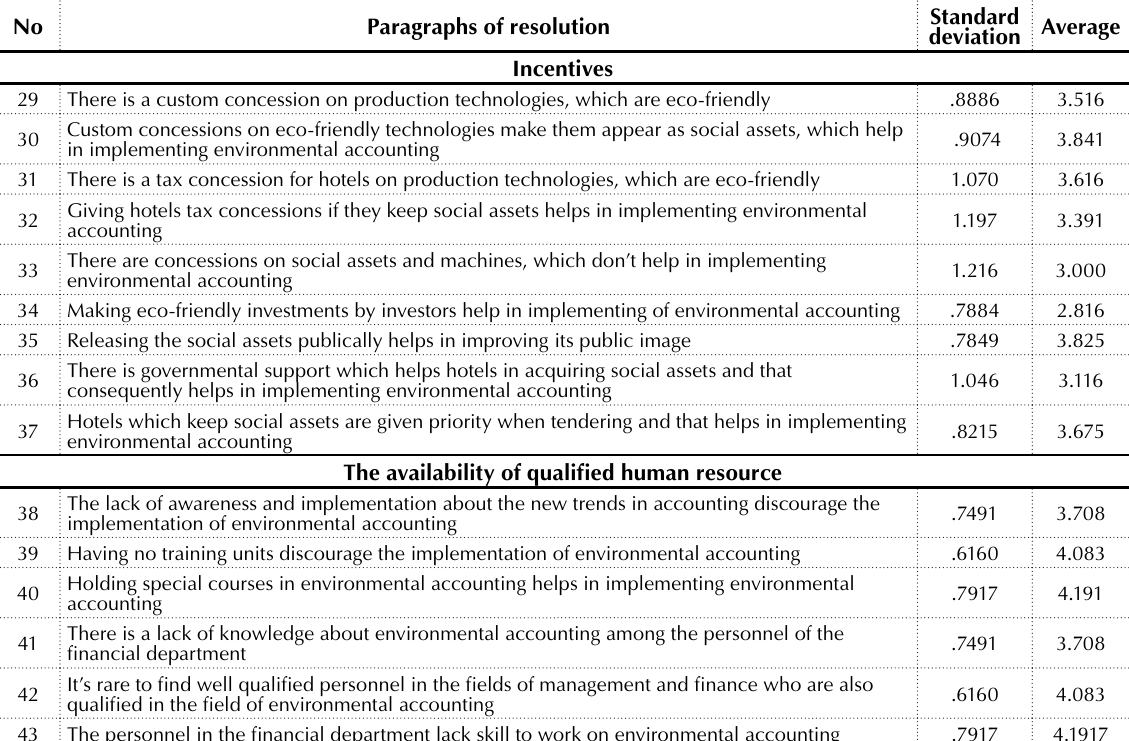
Table 11 (cont.). The mean and the standard